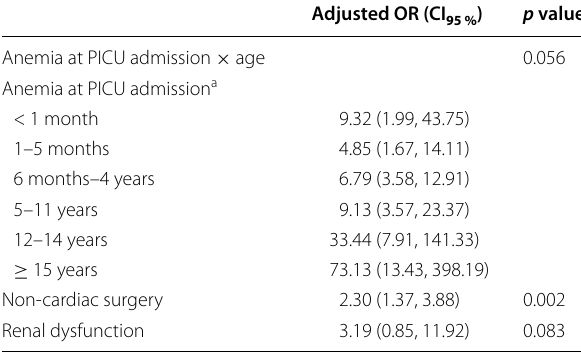
Table 3 Multivariable analysis: risk markers of anemia at PICU